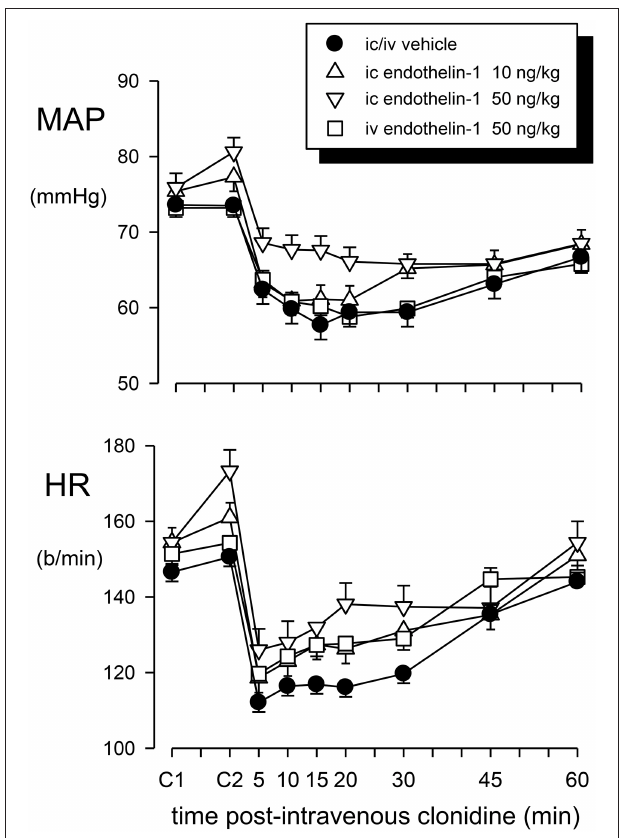
FIGURE 2 | Mean arterial pressure (MAP) and heart rate (HR) responses to intravenous (iv) injection of clonidine (20 µ g/kg) over a 60 min time course following vehicle pretreatment (closed circles) or pretreatment with endothelin–1: 50 ng/kg intravenously (squares), 10 ng/kg intracisternally (ic) (triangle up) or 50 ng/kg intracisternally (triangle down). C1 indicates initial basal values and C2 indicates MAP and heart rate 30 min after pretreatment injection. Error bars are ± 1 SEM from analysis of variance and indicate variation between animals.